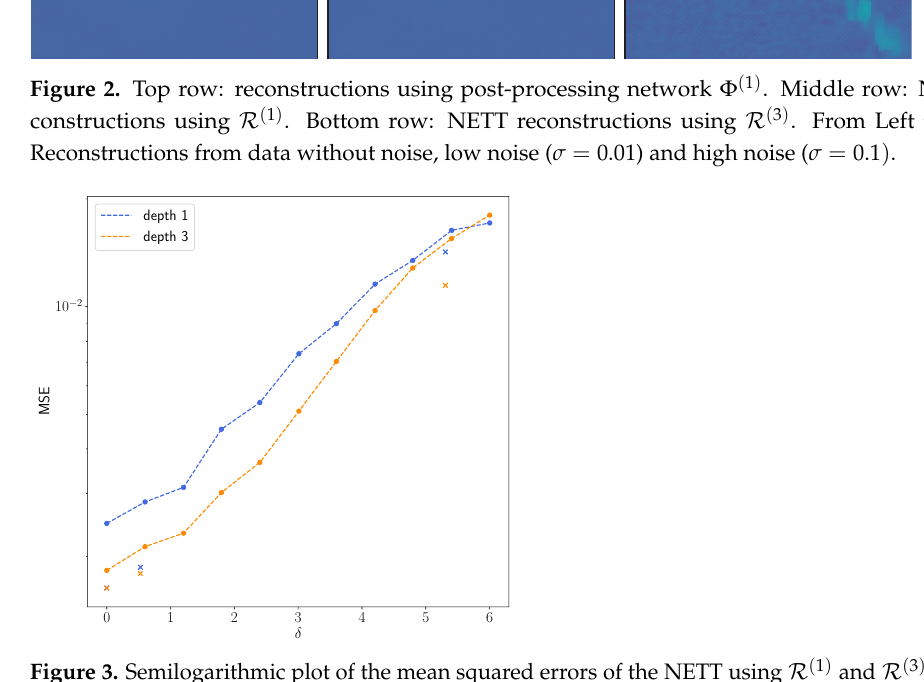
Figure 3. Semilogarithmic plot of the mean squared errors of the NETT using ing on the noise level. The crosses are the values for the phantoms in Figure 2.